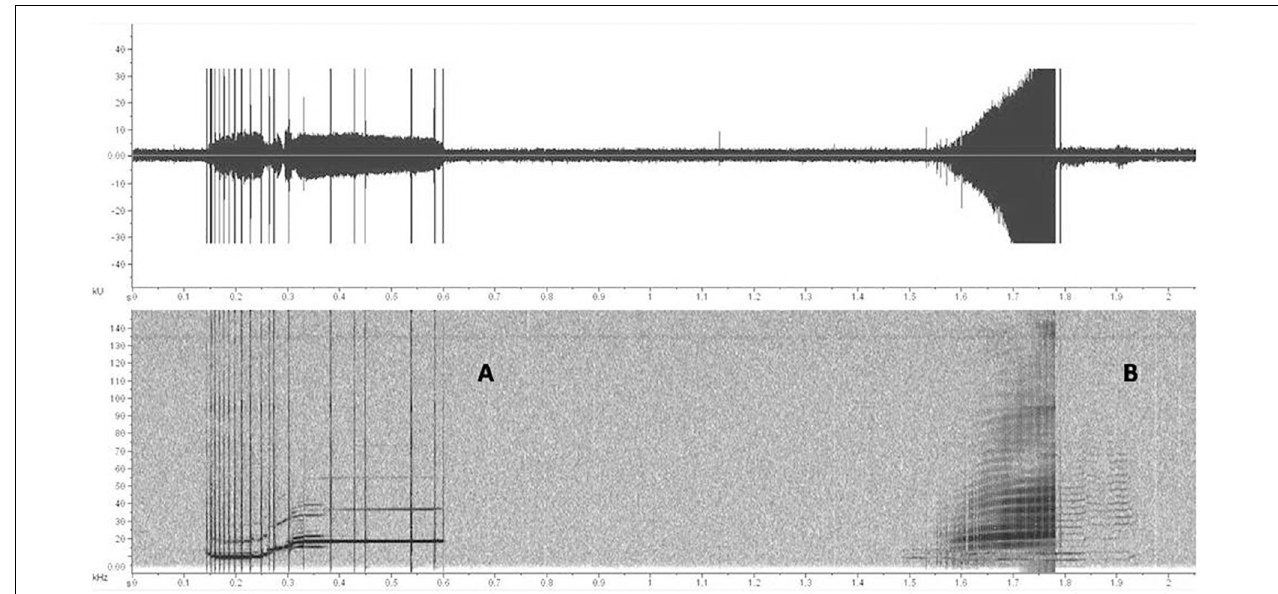
FIGURE 2 | Spectrogram (1024 Fast Fourier Transform size and a Blackmann-Harris window) and waveform (graph energy vs. time) of two complex calls: (A) a combined whistle-click train signal; (B) overlap of a tonal and a burst pulsed component.